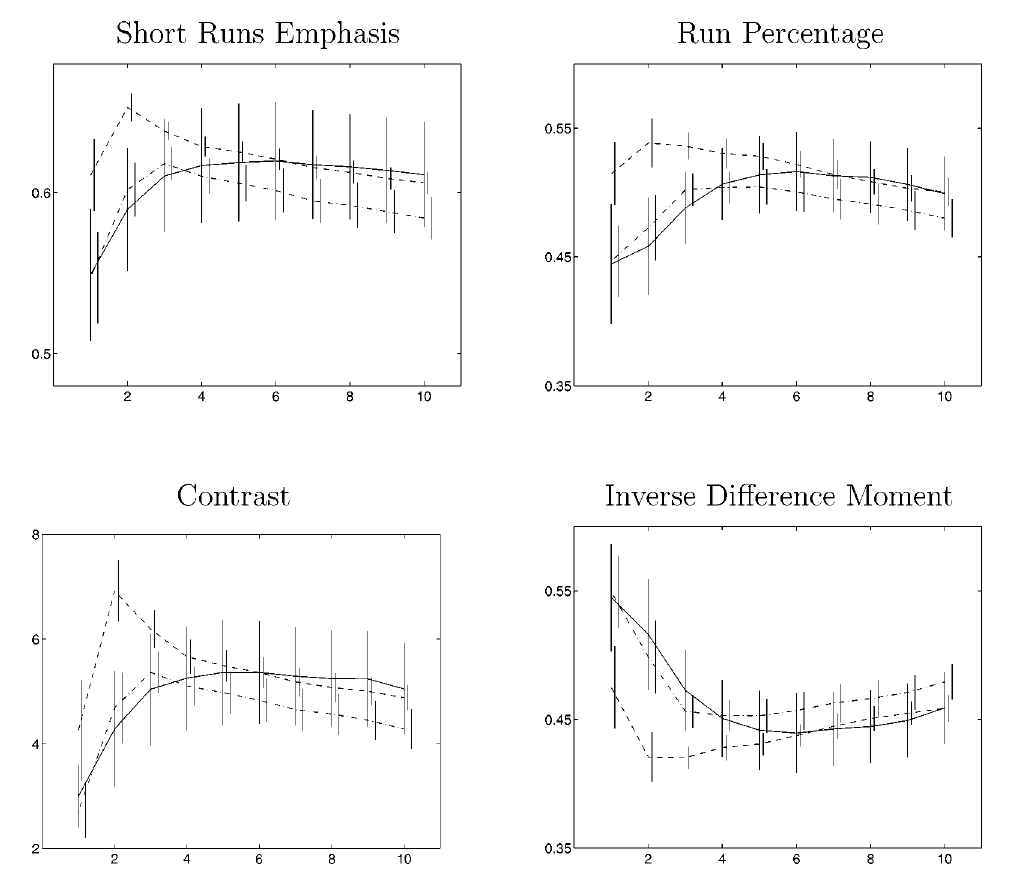
Fig. 9. Some examples of Gray Level Coocurrence Matrix and Gray Level Run Length Matrix features that benefit from being applied separately to the outer parts of the cell nuclei. Average features for samples from the normal+regenerating (- -), noduli (- (cid:1) ) and tumor (—) classes are plotted versus segment. The standard deviation of each feature for each class and segment is indicated. This is based on the mean feature values obtained for each sample in each